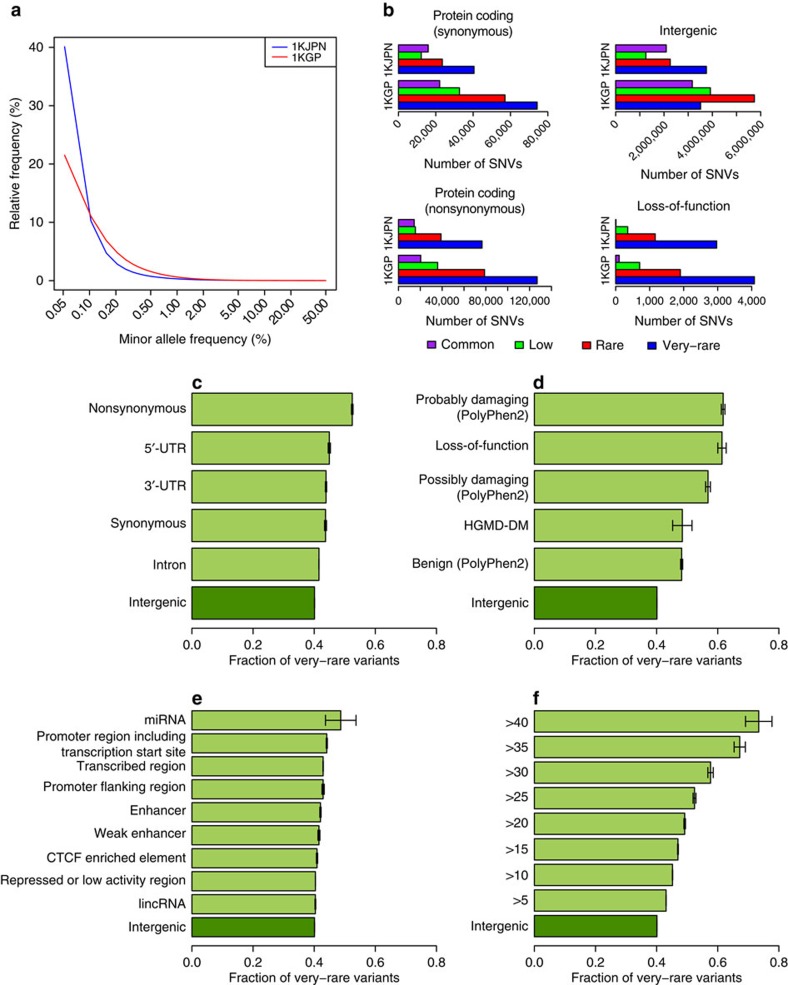
The impact of very-rare variants on genomic regions and functional categories.(a) The SFSs of intergenic region for SNVs of 1KJPN (blue) and 1KGP (red). (b) The numbers of SNVs observed in 1KJPN and 1KGP are depicted as four functional categories. The fraction of very-rare variants observed in 1KJPN are depicted with 95% binomial confidence interval according to (c) genomic region, (d) probable consequences for coding regions, (e) in noncoding regions and (f) for scaled C scores. Because the number of genotyped individuals in the confidence SNVs is different among sites because of the individual depth filter, we applied a hypergeometric projection65, which subsamples each variant down to a sample size of 963 (90% of 1,070 samples) to obtain the SFSs of the confidence SNVs for a,c–f.